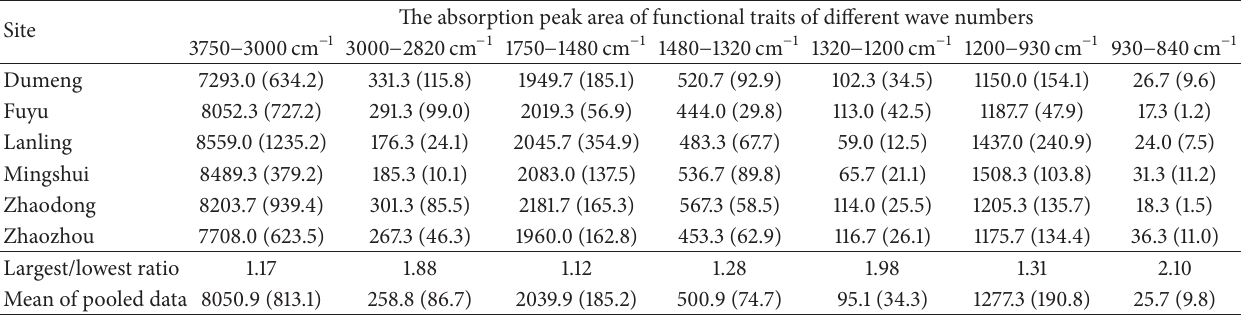
Table 4: Differences of absorption peak area of functional traits of T-GRSP at different sites in Songnen Plain. The absorption peak area of functional traits of different wave Site